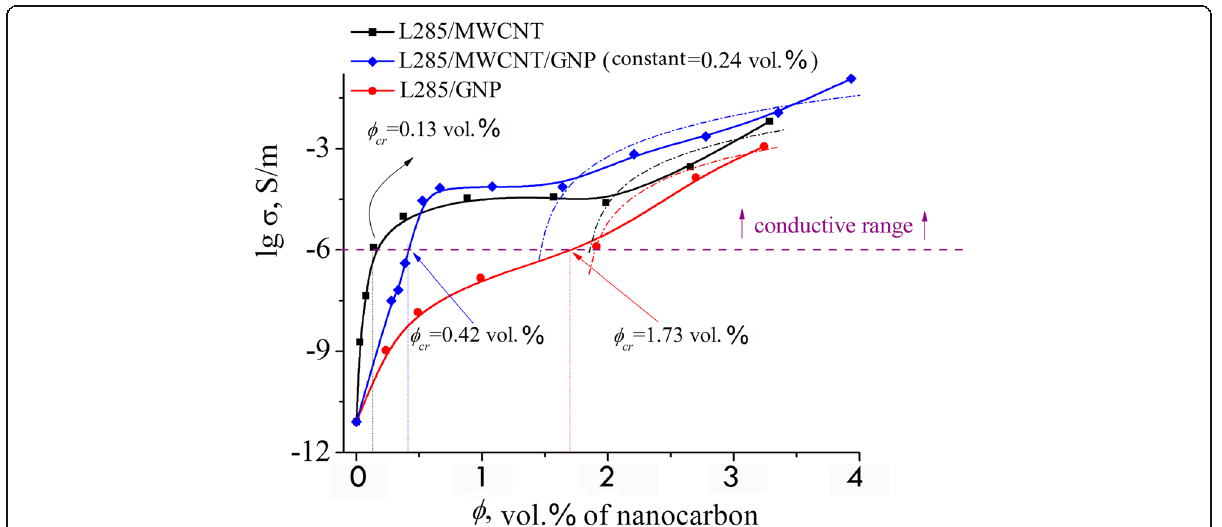
Fig. 2 Electrical conductivity of composites as a function of nanocarbon content. Solid line the experimental curves; dotted line the calculated curves according to Eq.